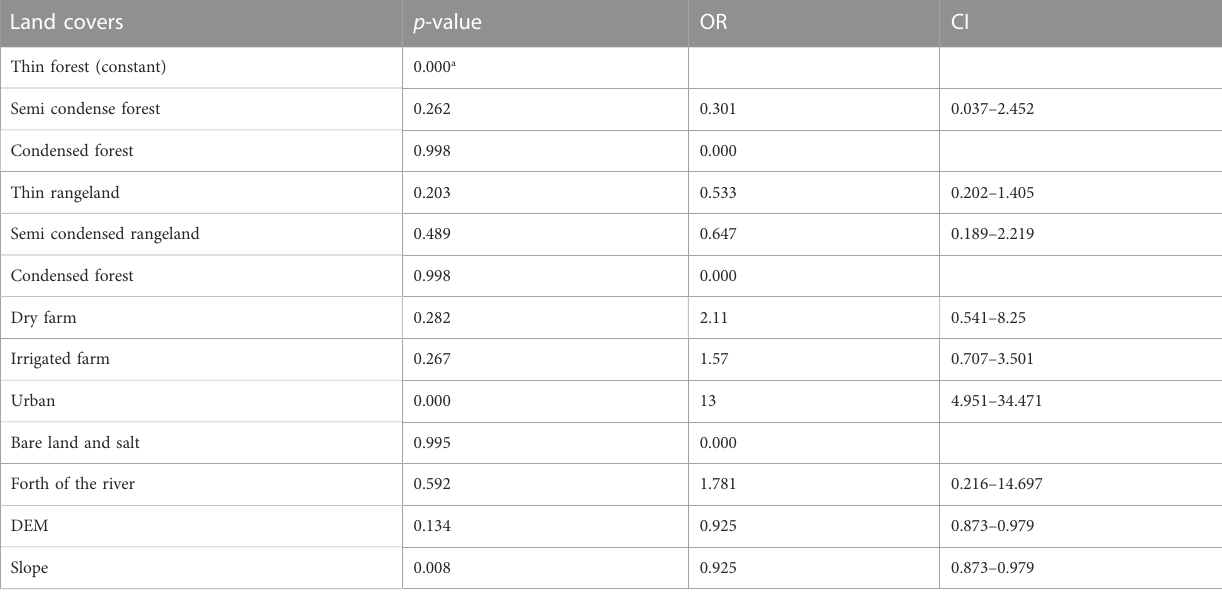
TABLE 2 Univariate analysis of the effect of environmental factors on asthma